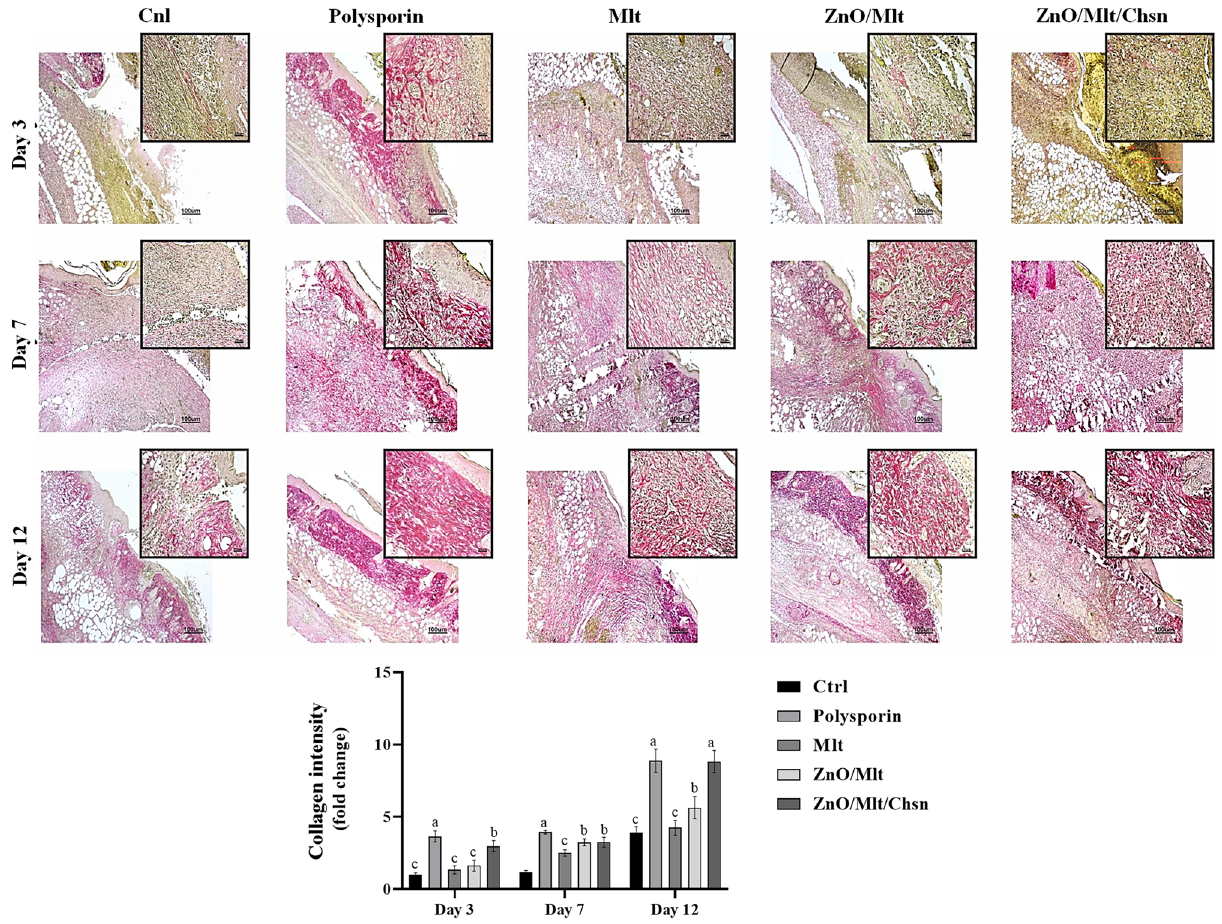
Figure 11. Representative photomicrographs on days 3, 7, and 14 stained with the Sirius red staining for the wound area in Cnl, polysporin, Mlt, ZnO/Mlt, and ZnO/Mlt/Chsn groups. See the collagen synthesis and well- recovered epidermis and dermis of the wound in ZnO/Mlt and ZnO/Mlt/Chsn versus the other